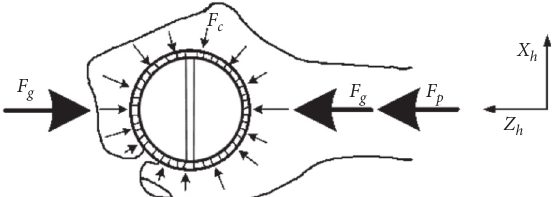
F g ), c ), grip force (